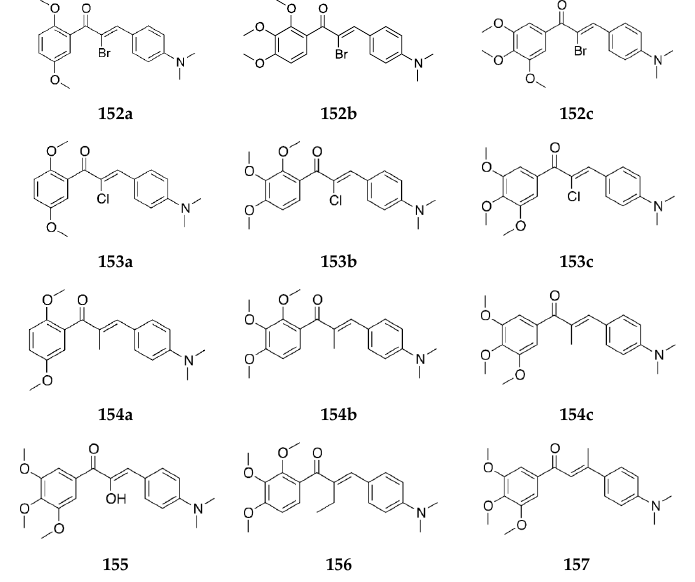
Figure 56. Chemical structure of N,N -dimethyl-4′-aminochalcone derivatives with methoxy substitutions on ring A and substitutions on C=C of chalcone. In addition to the dimethylamino-chalcone compounds, the antimitotic activity of some diethylamino-chalcone compounds was also reported along with two other alkyl substitutions on the amino group at position 4′ (Figure 57).